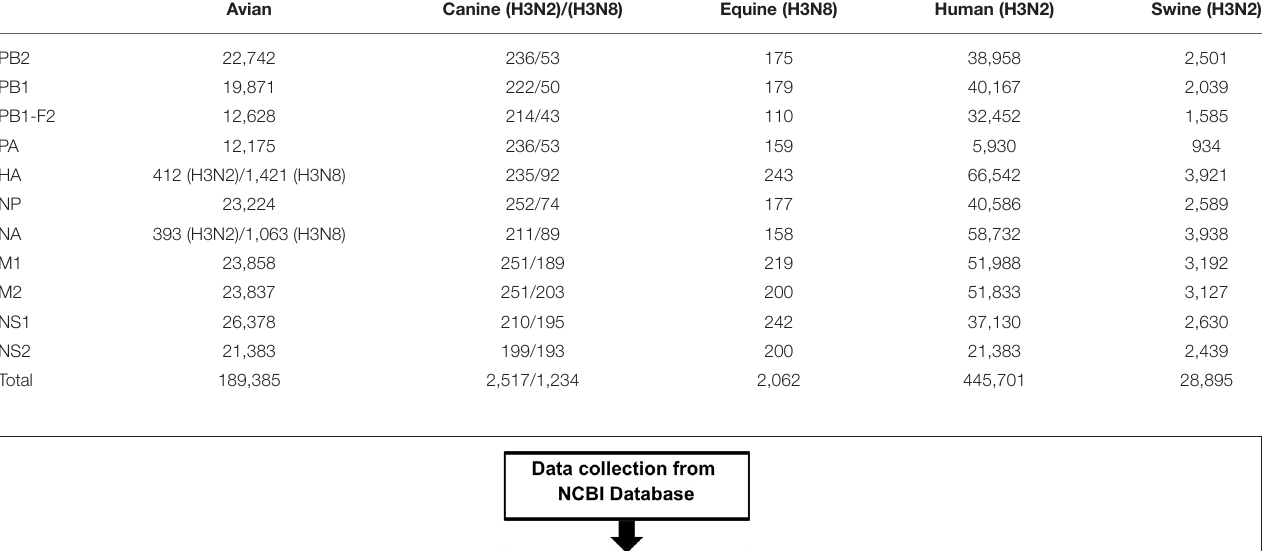
TABLE 1 | The number of protein sequences of target finally used in this study.